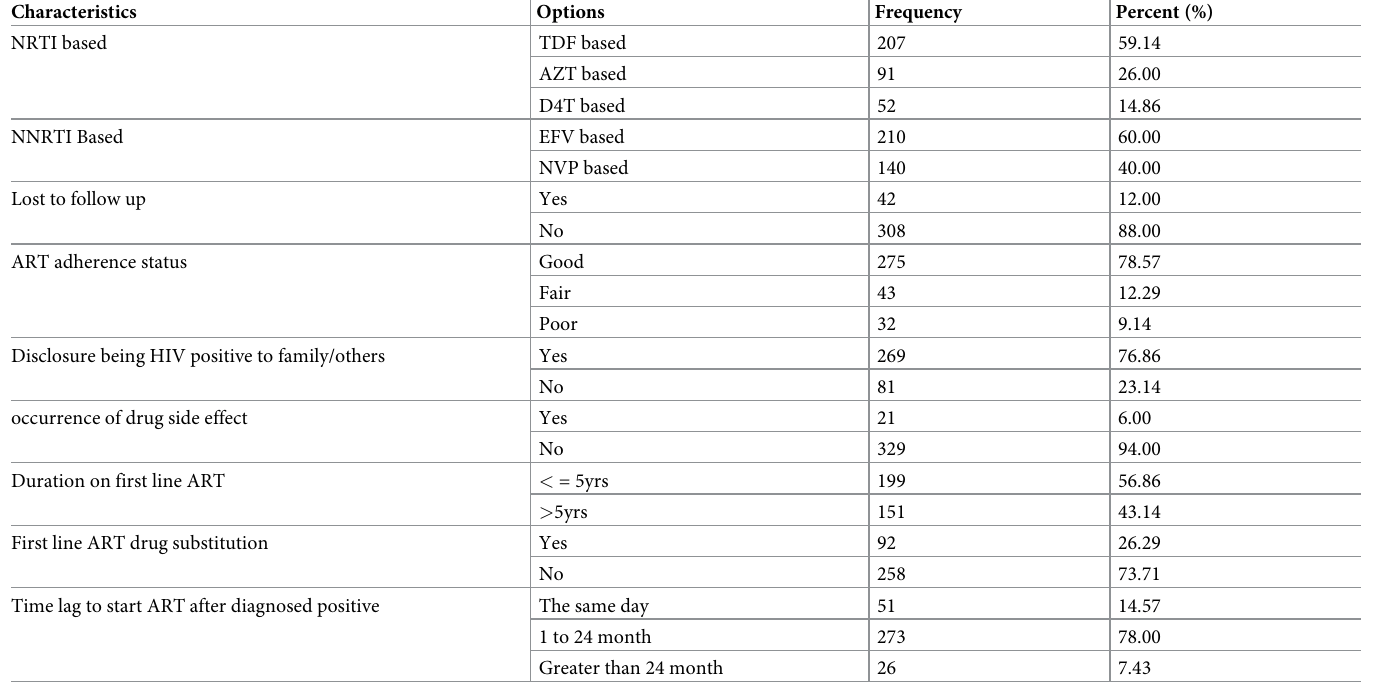
Table 3. ART treatment related condition of patients taking ART drugs at public health facilities in South West Shoa Zone, 2019. Characteristics